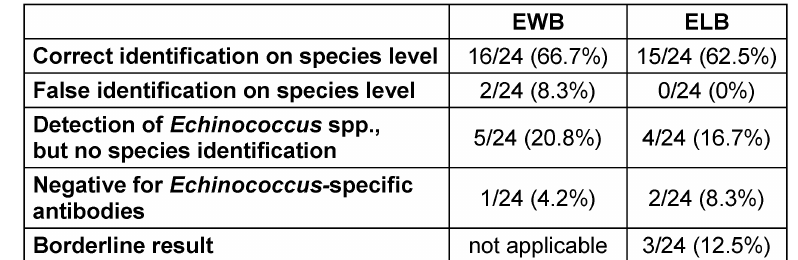
Table 4: Results of EWB and ELB in all cases of proven and probable Echinococcus infection with species identification